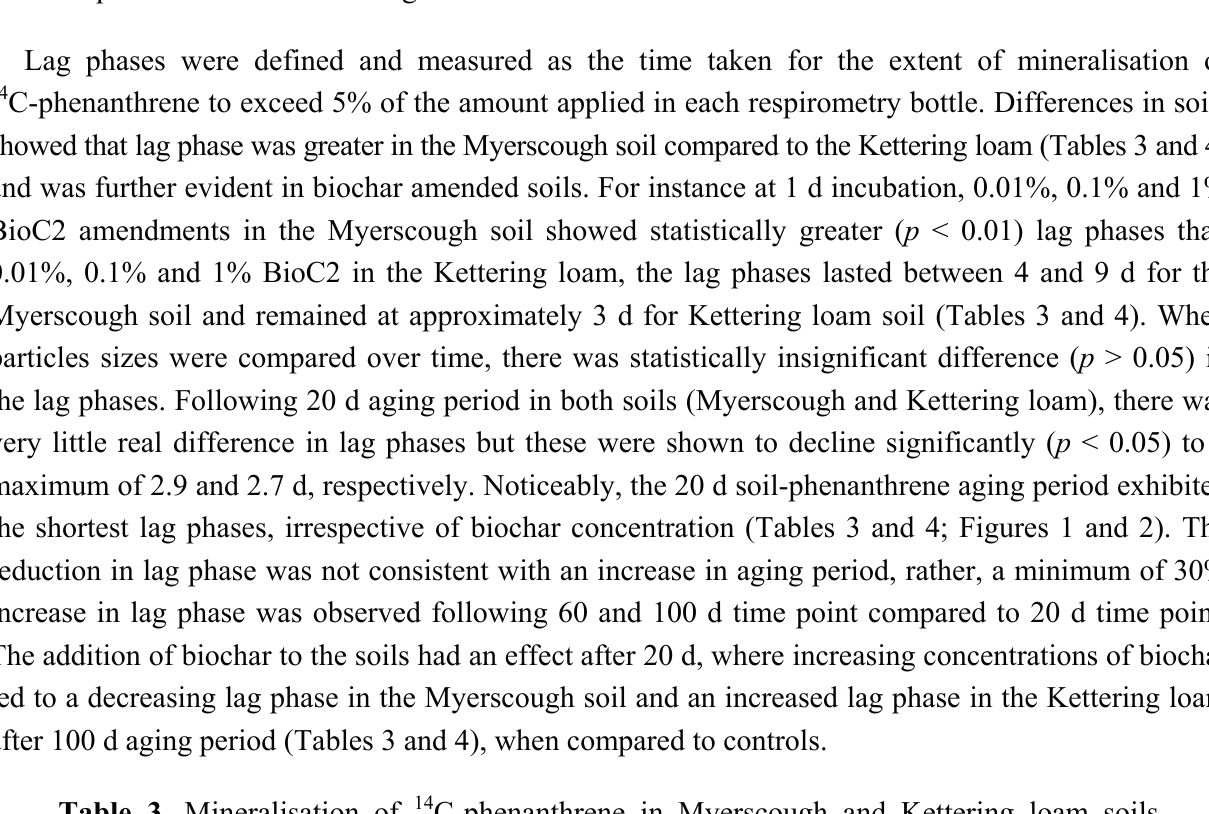
Table 3. Mineralisation of 14 C-phenanthrene in Myerscough and Kettering loam soils amended with 0%, 0.01%, 0.1% and 1% of ≤ 2 mm biochar (BioC1). Errors represent standard error of mean (SEM) of triplicate samples ( n =